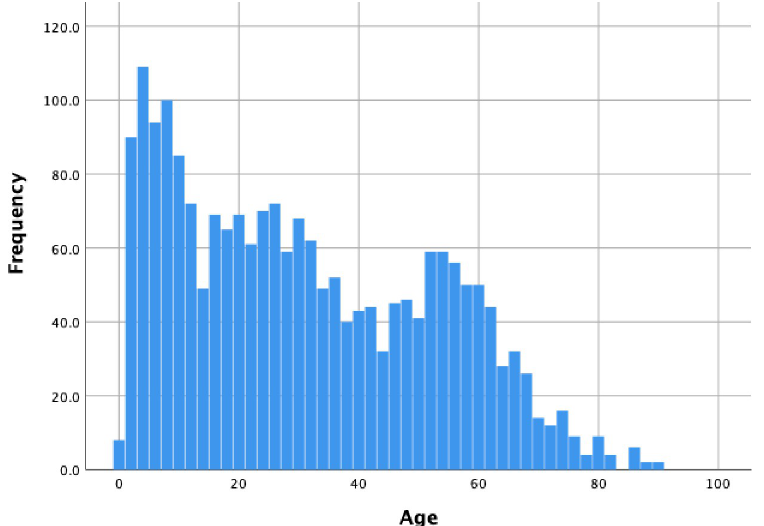
Fig 1. Histogram showing the age distribution of enrolled participants.